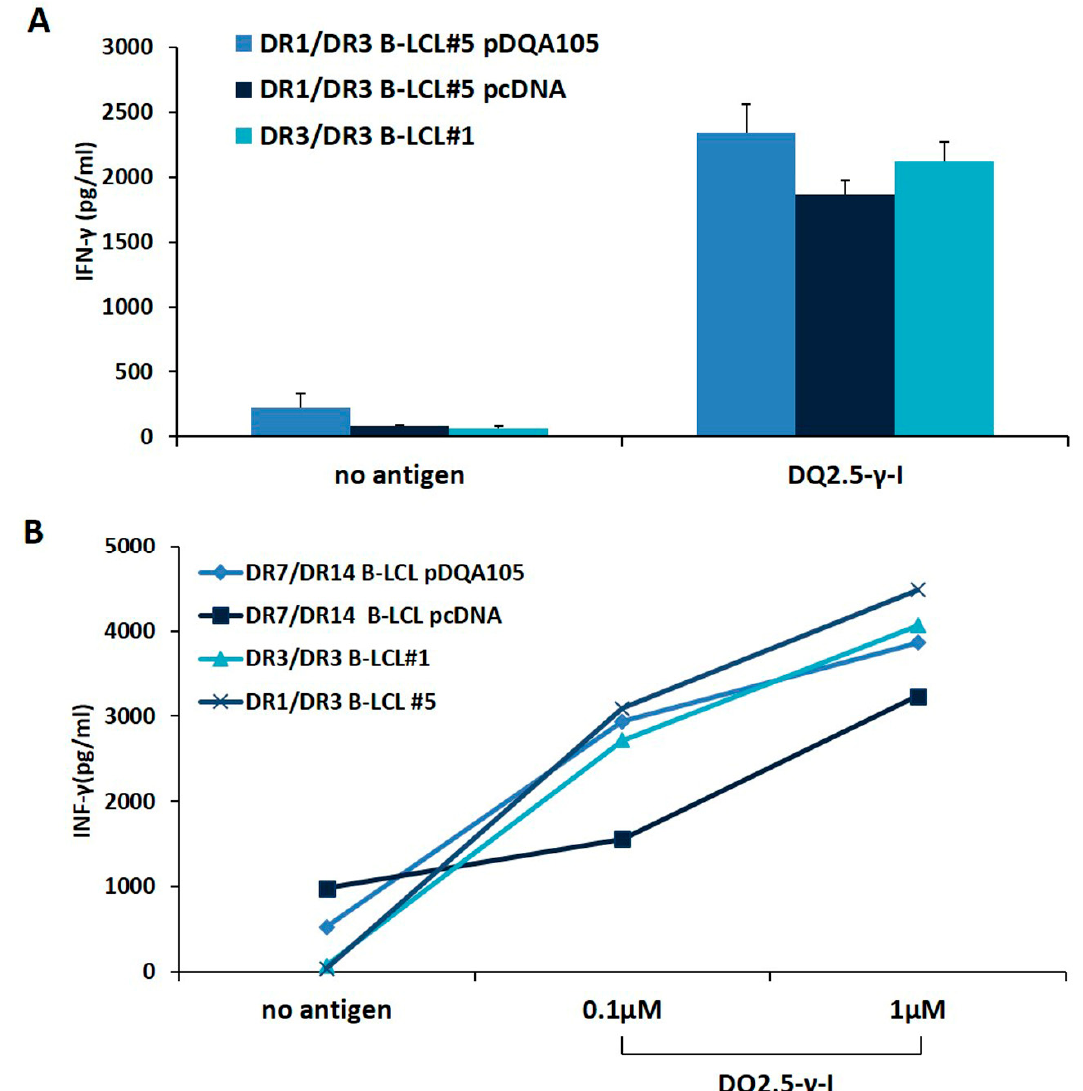
Figure 4. The antigen presenting properties of B-LCLs transfected with pDQA105. The antigen presenting capability of B-LCL pulsed with immunodominant DQ2.5- γ 1 gliadin peptide were measured by assessing the activation of intestinal CD4 + T cell line. Panel A shows the IFN- γ production by CD4 stimulated by DR3 / DR3 B-LCL#1 and DR1 / DR3 B-LCL#5 transfected with pcDNA or pDQA105 constructs. Panel B shows the IFN- γ production by CD4 stimulated with DR3 / DR3 B-LCL#1, DR1 / DR3 B-LCL#5, and DR7 / DR14 B-LCL transfected with pcDNA or pDQA105 constructs.